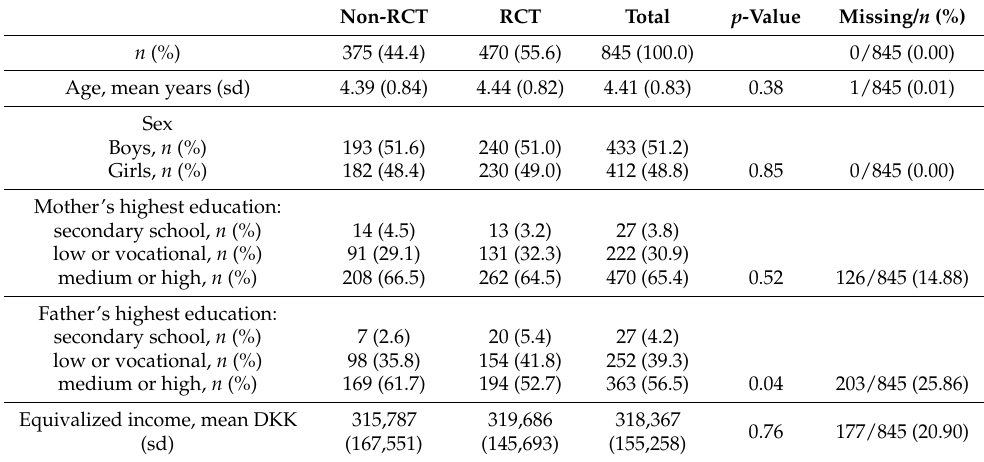
Table 2. Baseline description of the cohort by participants and non ‐ participants in the RCT.